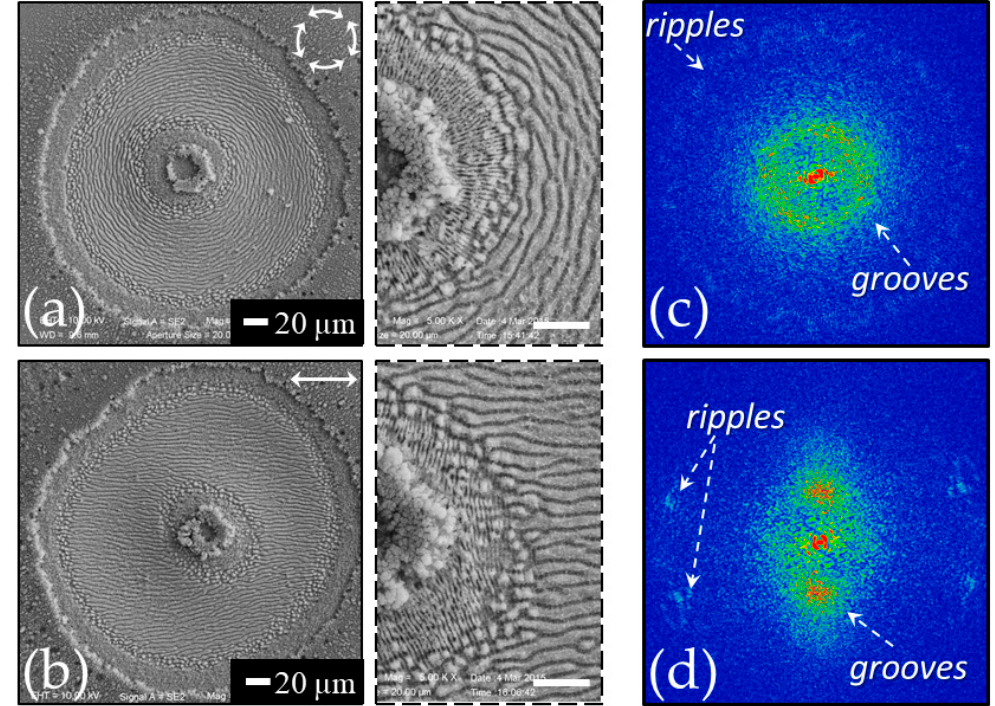
Figure 5. Two examples of craters produced by vector vortex beams with azimuthal (panel a ) and horizontal (panel b ) polarization. In both cases the irradiation sequence comprises N = 100 laser pulses at an energy E ≈ 50 µ J. The lateral insets in the dashed boxes reports zoomed views of the central region evidencing the grooves and ripples. The scale bars in the insets are 5 µ m. The right panels ( c , d ) show the 2D-FFT maps of the corresponding SEM image.